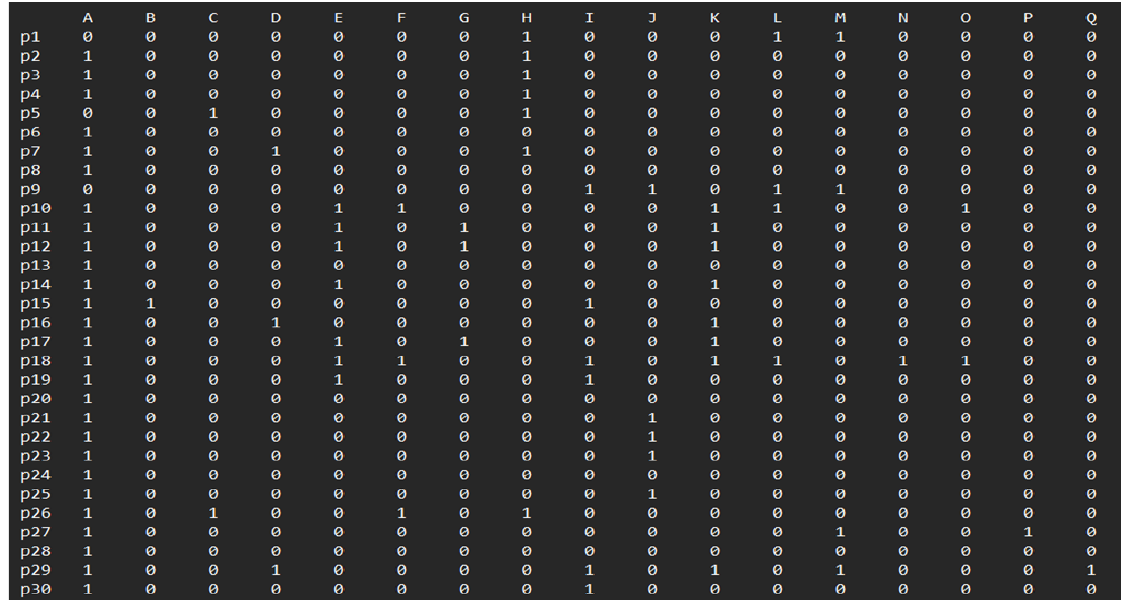
Figure S5. Binary data generated from visual analysis of banding pattern of Plasmid profile analysis of the 30 isolates (P1-P30). Columns: A: >10000, B: 10000bp, C: 9000bp, D: 8000bp, E: 7000bp, F: 6000bp, G: 4500bp, H: 3750bp, I: 3500bp, J: 3250bp, K: 3000bp. L: 2500bp. M: 2100bp, N: 2000bp, O: 1750bp, P: 1500bp, Q: